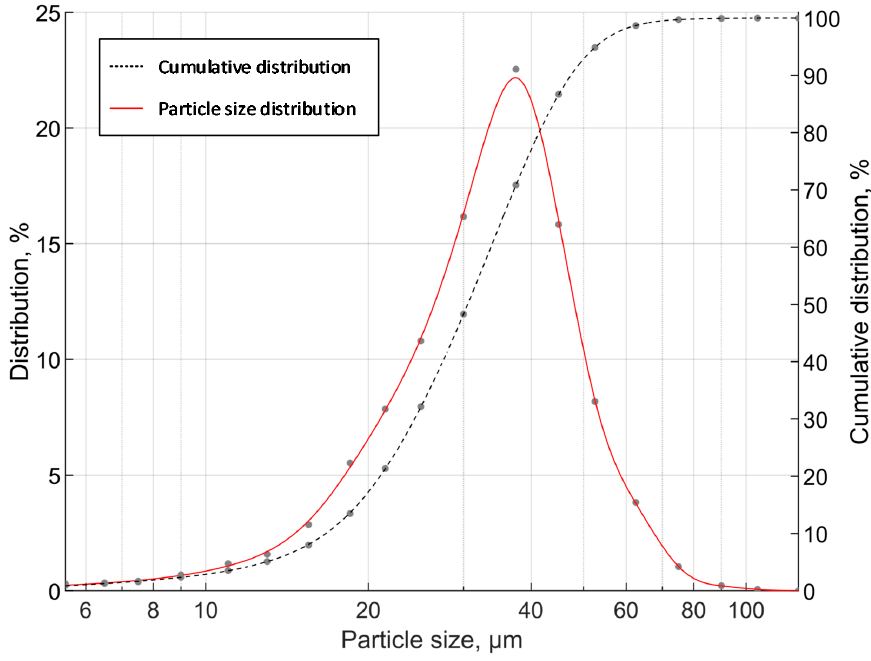
Figure 5. PSD of the diffusion-bonded/diffusion-alloyed FC-0208 powder.